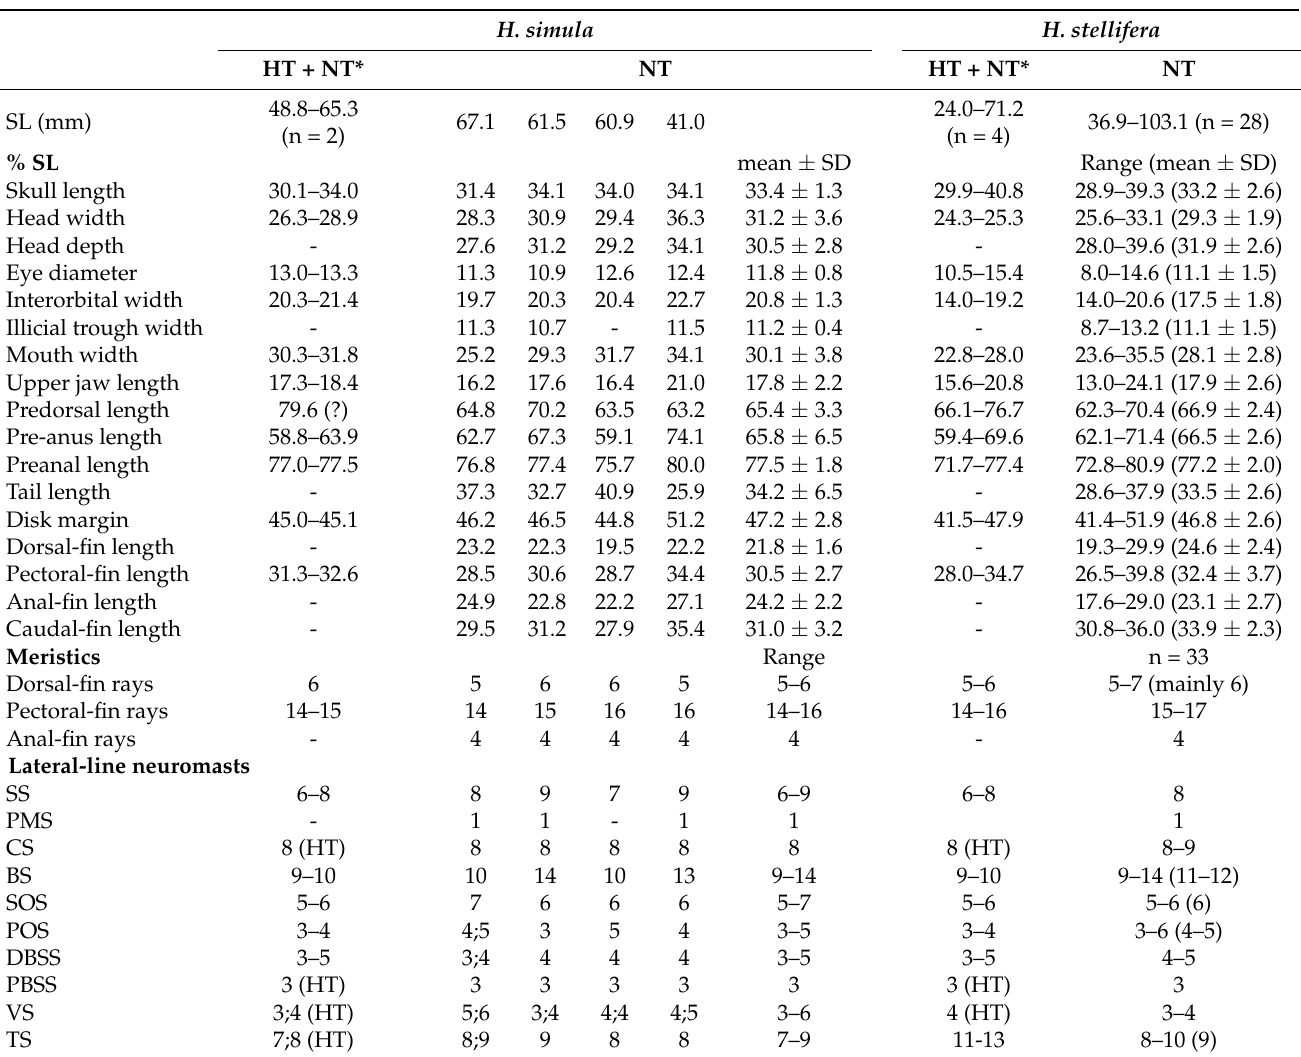
Table 9. Morphometric and meristic data of H. simula and H. stellifera . * Data taken from